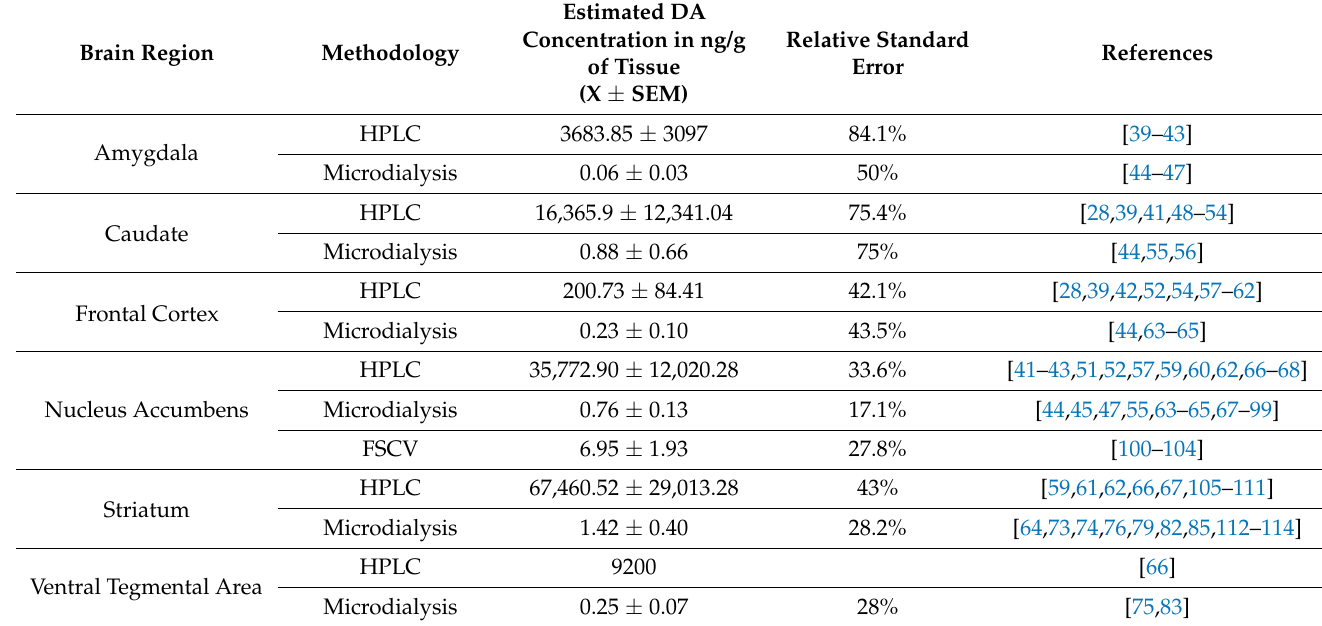
Table 1. Estimated basal dopamine (DA) values. Abbreviations: High Performance Liquid Chromatogrphy (HPLC); Fast Scan Cyclic Voltammetry (FSCV).